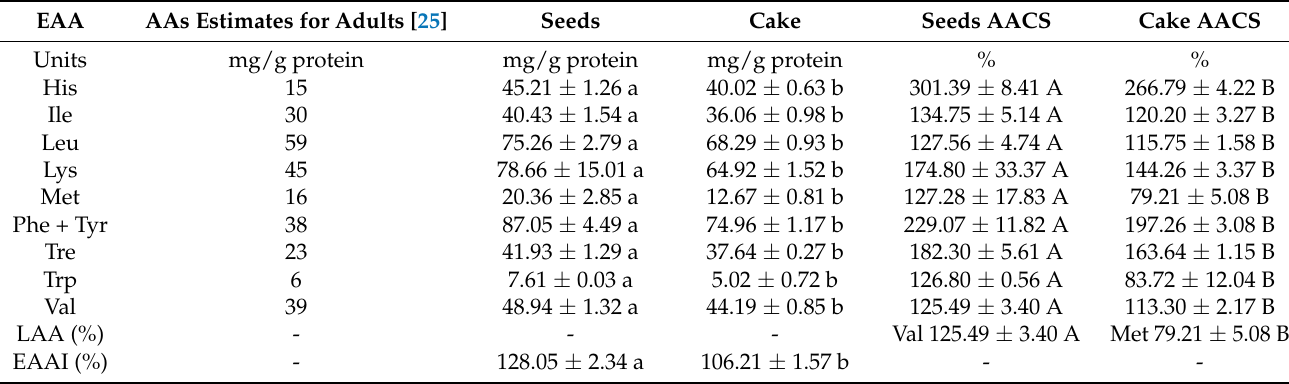
Table 4. Protein quality of chia seeds and